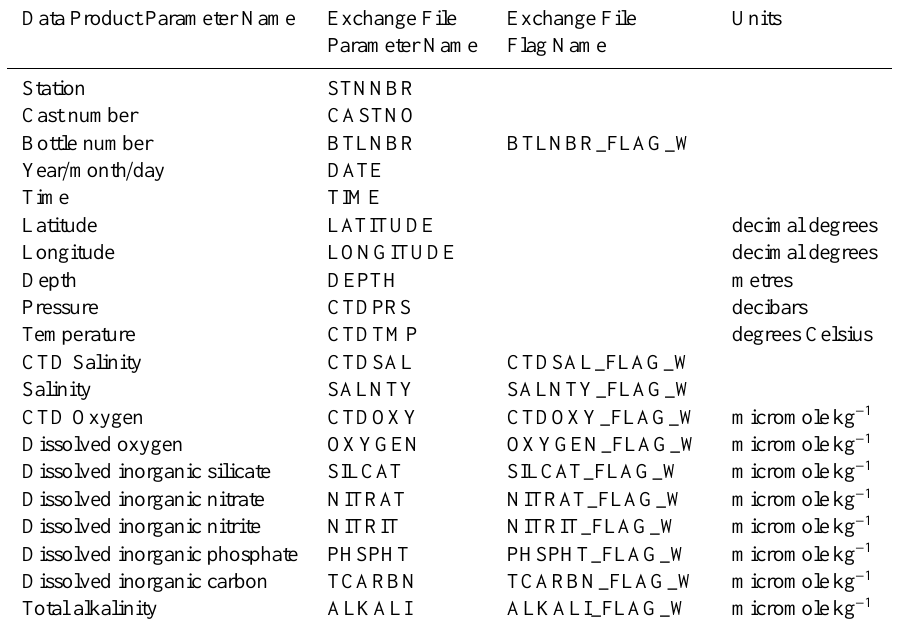
Table 1. List of parameters from the Rockall Trough as seen in the CDIAC